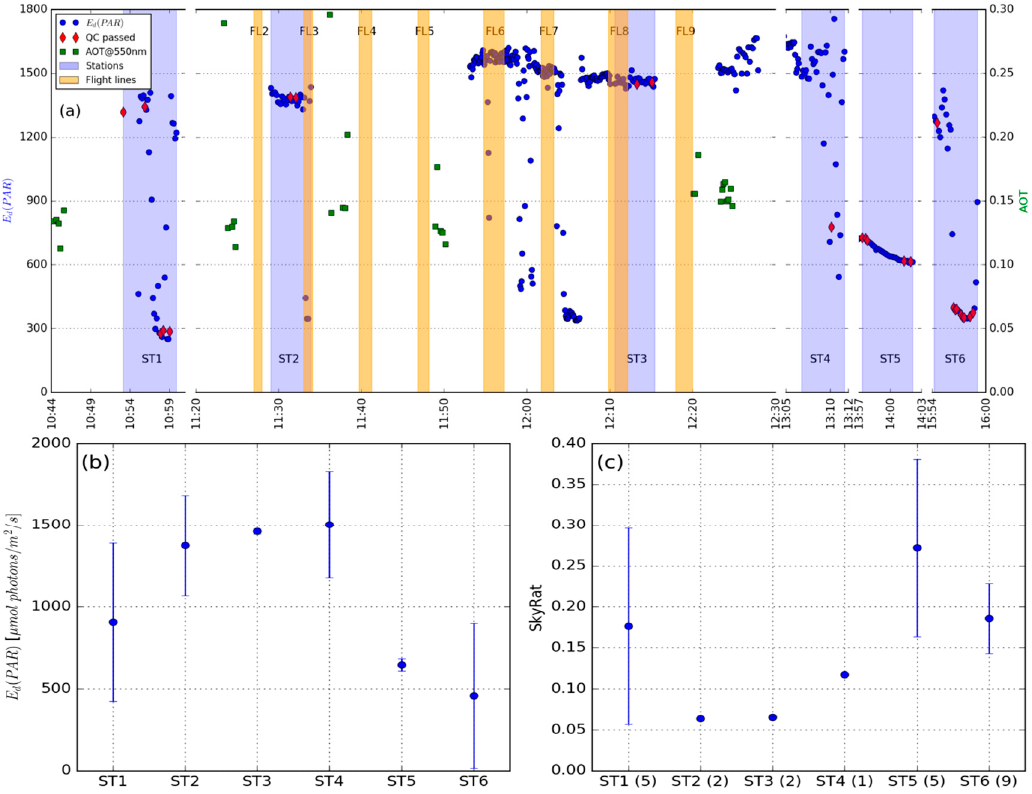
Figure 2. ( a ) In situ E d (PAR) and AOT measurements taken during the campaign. In situ observations used for station reference spectra are marked with red diamonds. Orange shading indicates the times of airborne flight lines, and blue shading the times of station measurements; ( b ) Median and standard deviation of E d (PAR) from all 30 measurements recorded at each station; ( c ) SkyRat based on QC passed measurements for calculation of R rs (number of valid observations are shown in horizontal axis label). The SkyRat error bars for stations ST2-ST4 are not shown, as there were <3 valid measurements at these stations.